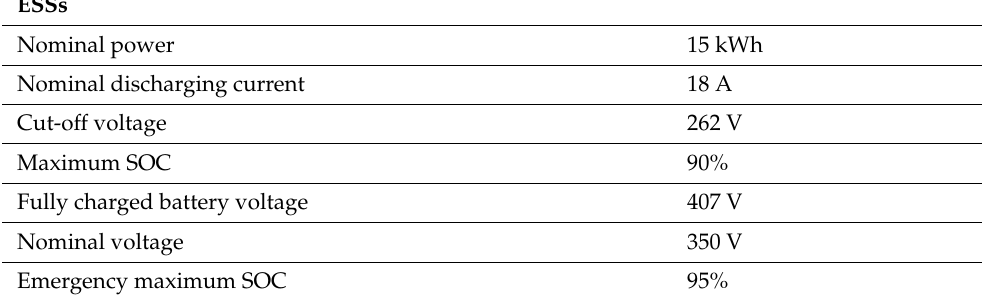
Table A1. System